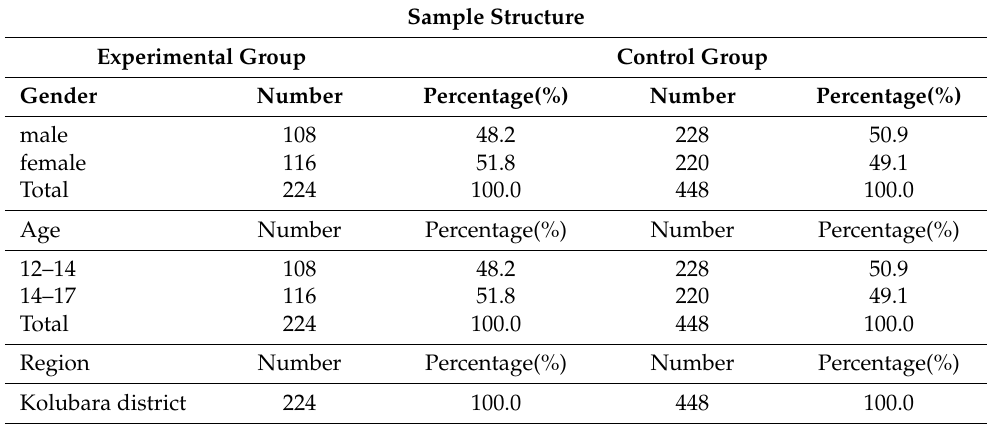
Table 4. Structure of the dataset used.